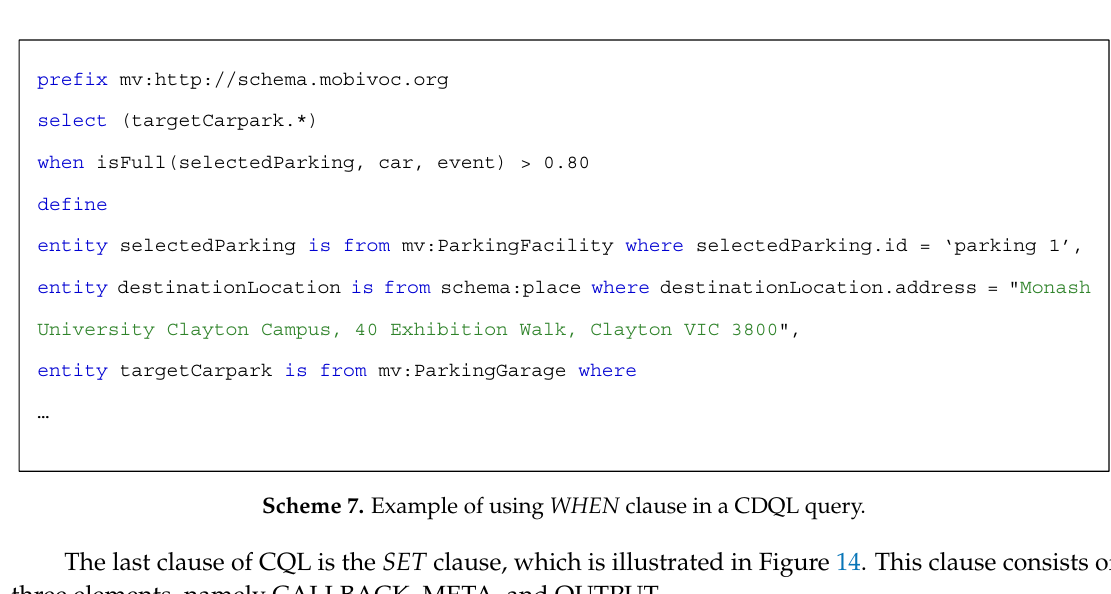
Scheme 7. Example of using WHEN clause in a CDQL query.